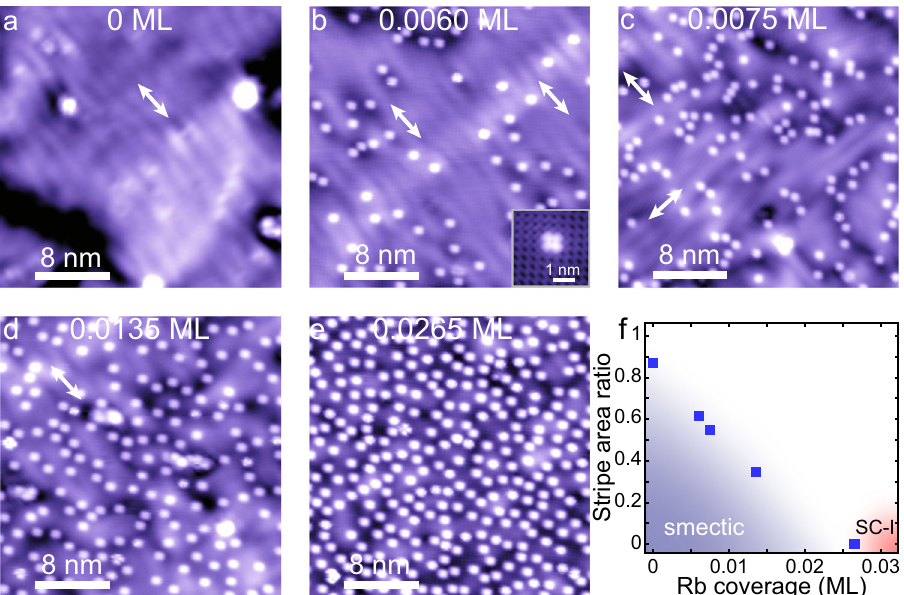
Fig. 3 Suppression of smectic phase in 2 UC FeSe by Rb surface doping. a – e Topographic images of 2 UC FeSe with surface Rb doping at various coverages: a 0 ML (30 nm × 30 nm; set point, V s = 60 mV, I t = 30 pA), b 0.0060 ML (30 nm × 30 nm; set point, V s = 60 mV, I t = 50 pA), c 0.0075 ML (30 nm × 30 nm; set point, V s = 60 mV, I t = 40 pA), d 0.0135 ML (30 nm × 30 nm; set point, V s = 100 mV, I t = 20 pA), e 0.0265 ML (30 nm × 30 nm; set point, V s = 60 mV, I t = 50 pA). Inset of b : STM topographic image of a single Rb atom adsorbed on 2 UC FeSe (see Supplementary Fig. 10). f Doping dependence of stripe area ratio (shown in blue dots) estimated from ( a ) to ( e ) (see Supplementary Fig. 11). The blue and red shaded regions denote the smectic and superconducting states,